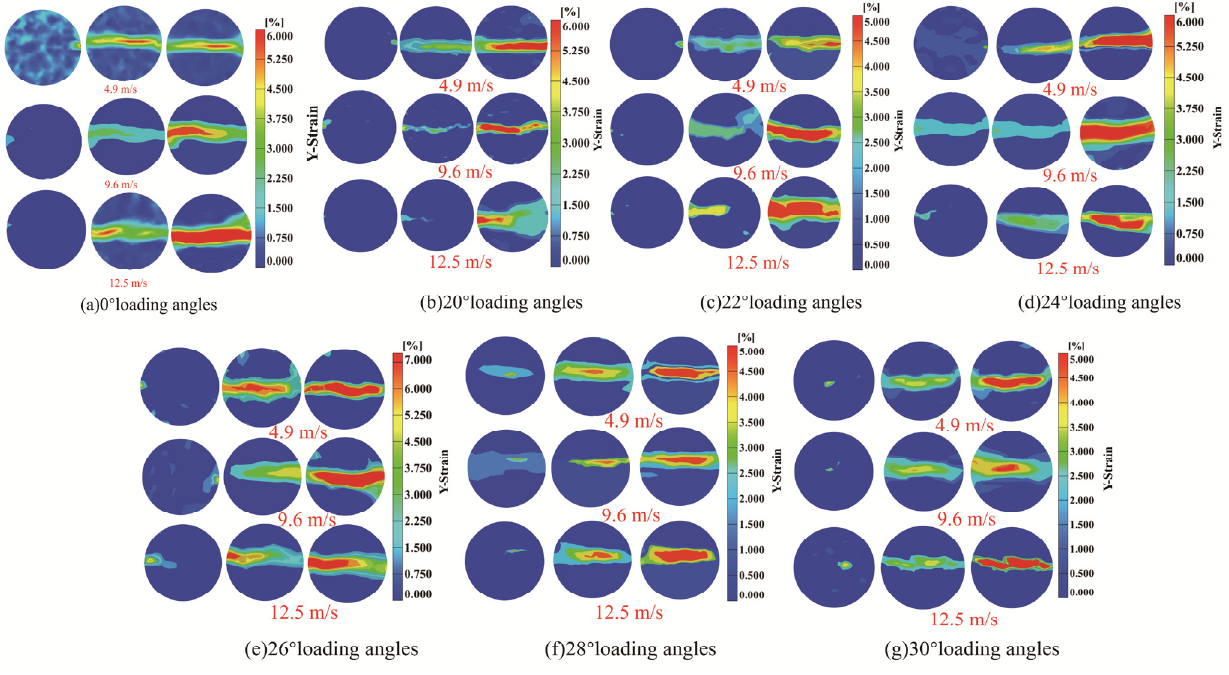
Figure 14. Vertical strain field of BD specimen at different loading angles and impact velocities.